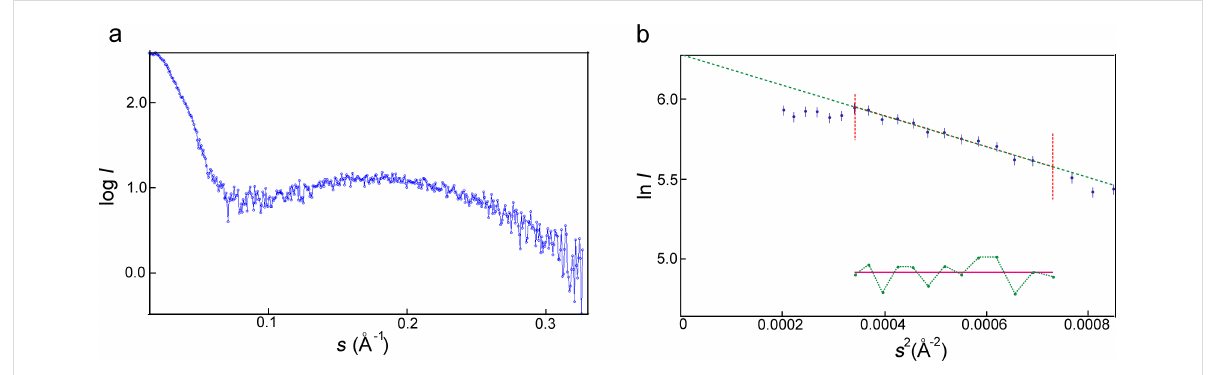
Figure 2: (a) SAXS diffraction intensity profile of an aqueous solution of 3 ( c 3 = 137 mg/mL) at 23 °C (logarithmic scale) after subtraction of the back- ground scattering (water); scattering vector s = 4 π ·sin θ / λ (Å − 1 ); X-ray wavelength λ = 1.5418 Å, (b) Guinier plot ln( I ) as a function of s 2 with linear regression of the curve; R g = 53.5 ± 1.8 Å, I (0) = 531 ± 18, r = 0.98.